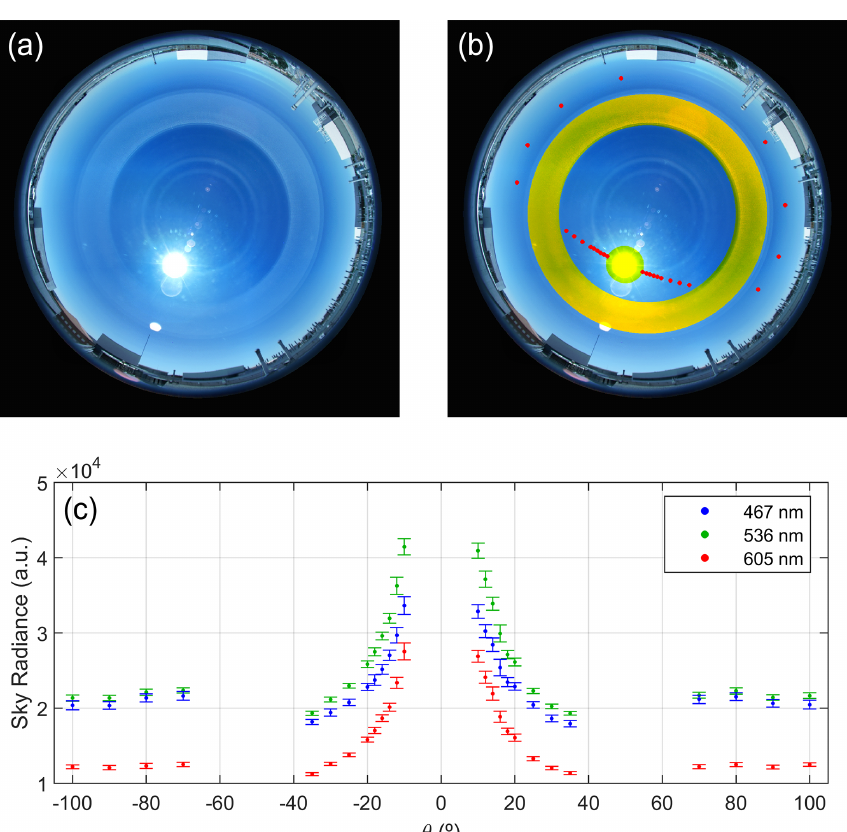
Figure 1. Tone map of the high dynamic range (HDR) sky image on 17 August 2019, 11:35UTC, at Valladolid (a, b) . Panel (b) also shows in yellow the sky areas banned to extract sky radiance and in red the points of the hybrid scan in this case. Panel (c) presents the relative sky radiance, in arbitrary units, extracted from the camera channels at three wavelengths as a function of the scattering angle ( (cid:50) ), corresponding to the sky points of the hybrid scan shown in panel (b)